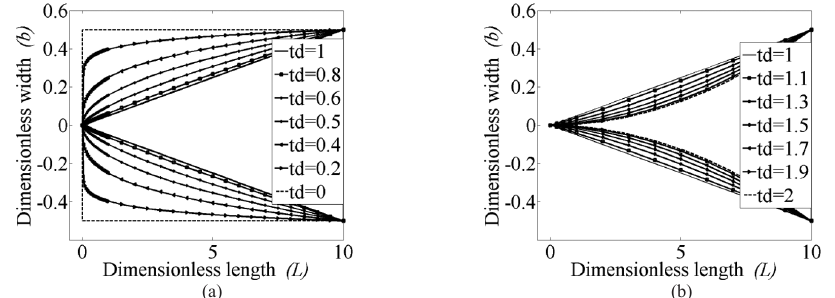
Fig. 7. The shapes of beams with various tapered orders: (a) tapered order varies from 0 to 1 with step 0.1, (b) tapered order varies from 1 to 2 with step 0.1.